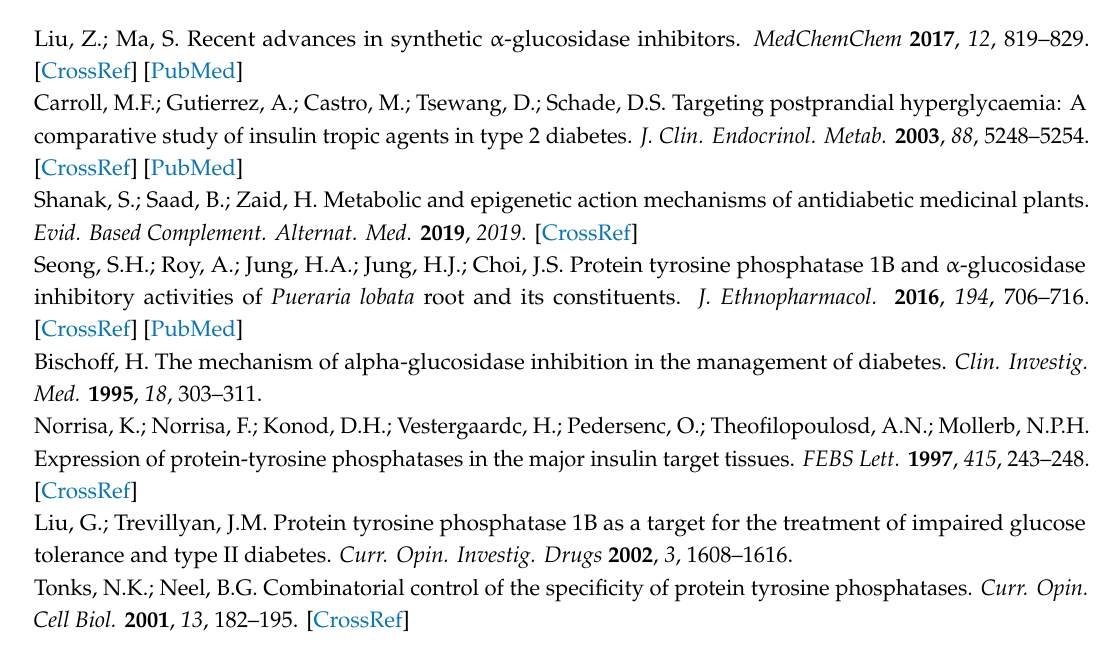
Figure S1: 1 H-NMR and 13 C-NMR spectra of compounds 2a – h , Table S1 : The sequence alignment of Saccharomyces cerevisiae α -glucosidase (maltase) with templates, PDB ID 3A47 and 3AXH, Figure S2: The Ramachandran plot of the comparative model of S. cerevisiae α -glucosidase, Figure S3: The superimposition of the comparative model of S. cerevisiae α -glucosidase with the crystal structure of β -glucosidase of S. cerevisiae (PDB ID 3A4A), Figure S4: The docked conformation of the test compounds at the binding site of α -glucosidase built model (PDB ID 3A4A), and Figure S5: The docked conformation of the test compounds at ( a ) the catalytic binding site of PTB1B, and ( b ) the allosteric binding site of